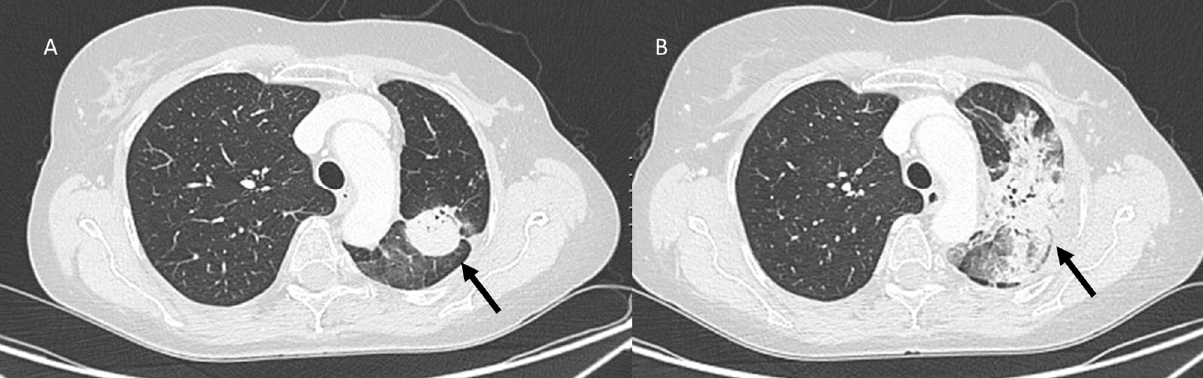
Figure 7. CT assessment of COVID-19 pneumonia ( A , B ): multifocal and bilateral distribution of ground-glass opacities (arrows). With regard to adverse reactions after vaccination for COVID-19, in the literature, there are several cases of RRP that see vaccination as a trigger (Figure 8). The latter, just like the COVID-19 infection, could determine an uncontrolled state of inflammation that favors the development of radiation recall [148,149]. On chest CT, scan areas of ground